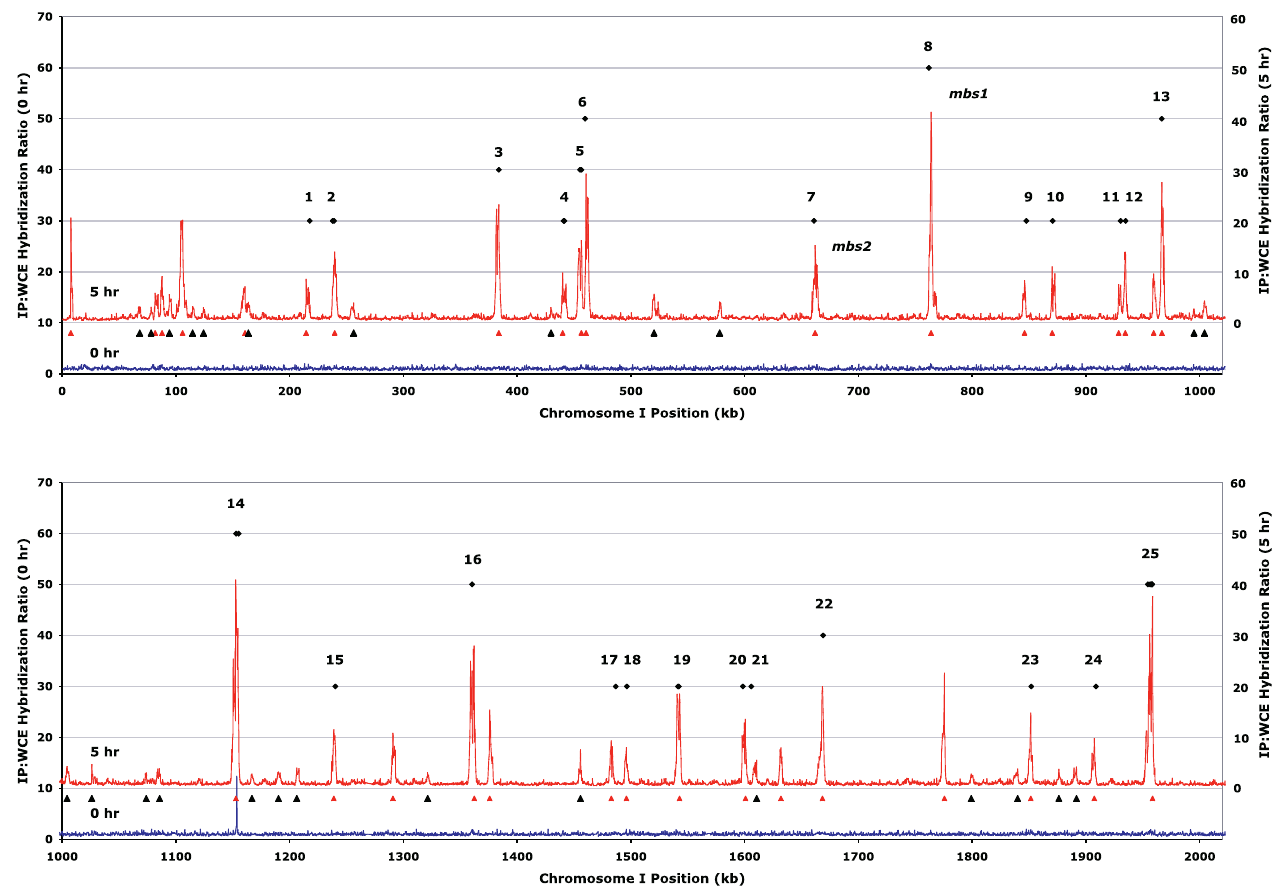
Figure 3. Close Correlation between DSBs and Rec12-DNA Linkages across 1.8 Mb of Chromosome I Microarray data from 0 h (blue line) and 5 h (red line) analyses of haploids are presented as in Figure 1. Numbered black diamonds indicate discernable DSB hotspots seen on Southern blots of DNA digested with a variety of enzymes that produce 10–100-kb fragments (see examples in Figures 2 and S6 for the Southern blots analyzed). Intensity and position data for mbs1 and mbs2 (numbers 7 and 8) are from [5,12]. Carets indicate weak (black) and prominent (red) Rec12 peaks identified by PeakFinder. The peak at 1,776 kb is at the rec12 gene and likely results from the rec12-FLAG allele used for microarray analysis; no DSB hotspot was evident by Southern blot analysis of rec12 þ strains (Figure S7).